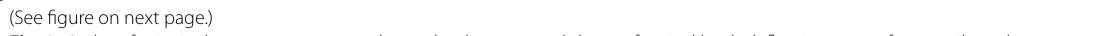
Fig. 3 A plot of principal component scores, cluster dendrogram, and shape of typical load–deflection curves for juvenile and mature wood. Note: PC1 and PC2 are the first and second principal components, respectively. The plotted codes in the top figure are Family ID. The vertical axis in the middle figure shows the distance between families based on the squared Euclidean distance using the Ward hierarchical clustering algorithm. Family groups I, II, III, and IV show types of load–deflection curve described as LDC-I, LDC-II, LDC-III, and LDC-IV in the bottom figure,